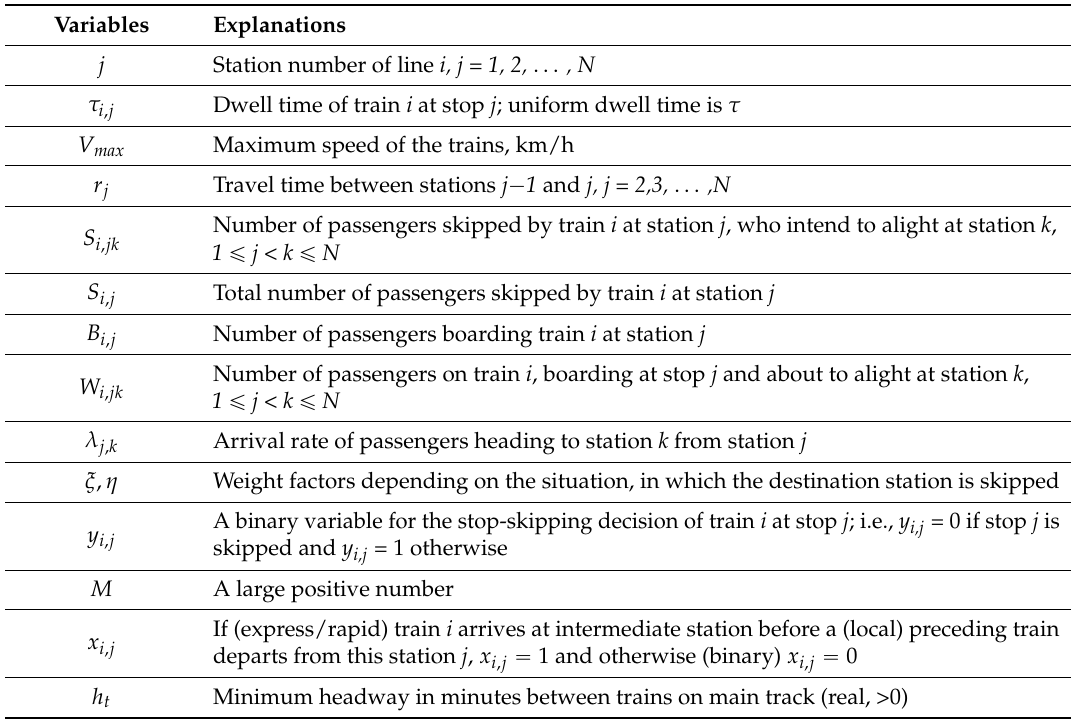
Table 1. Presentation of